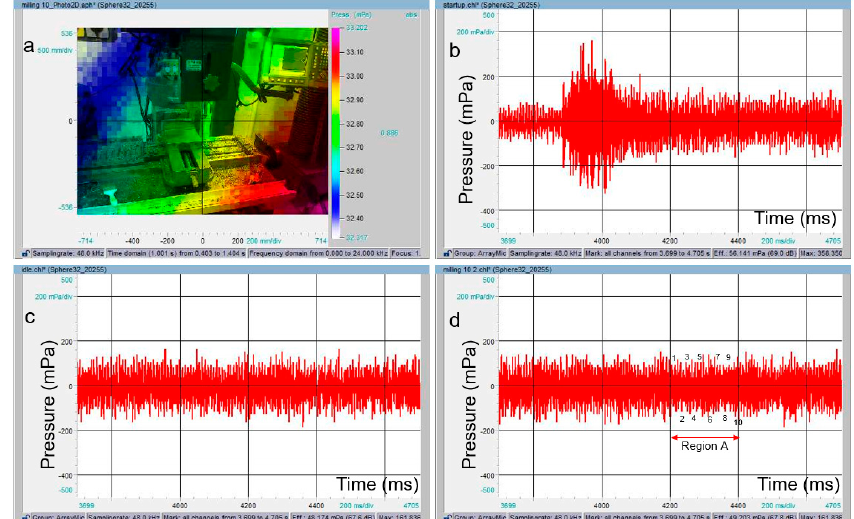
Figure 7. Acoustic emission for vertical milling machine ( a ) 2D image superimposed with noise mapping intensity; ( b ) noise emission during startup; ( c ) noise emission during idle speed; and ( d ) noise emission during load.